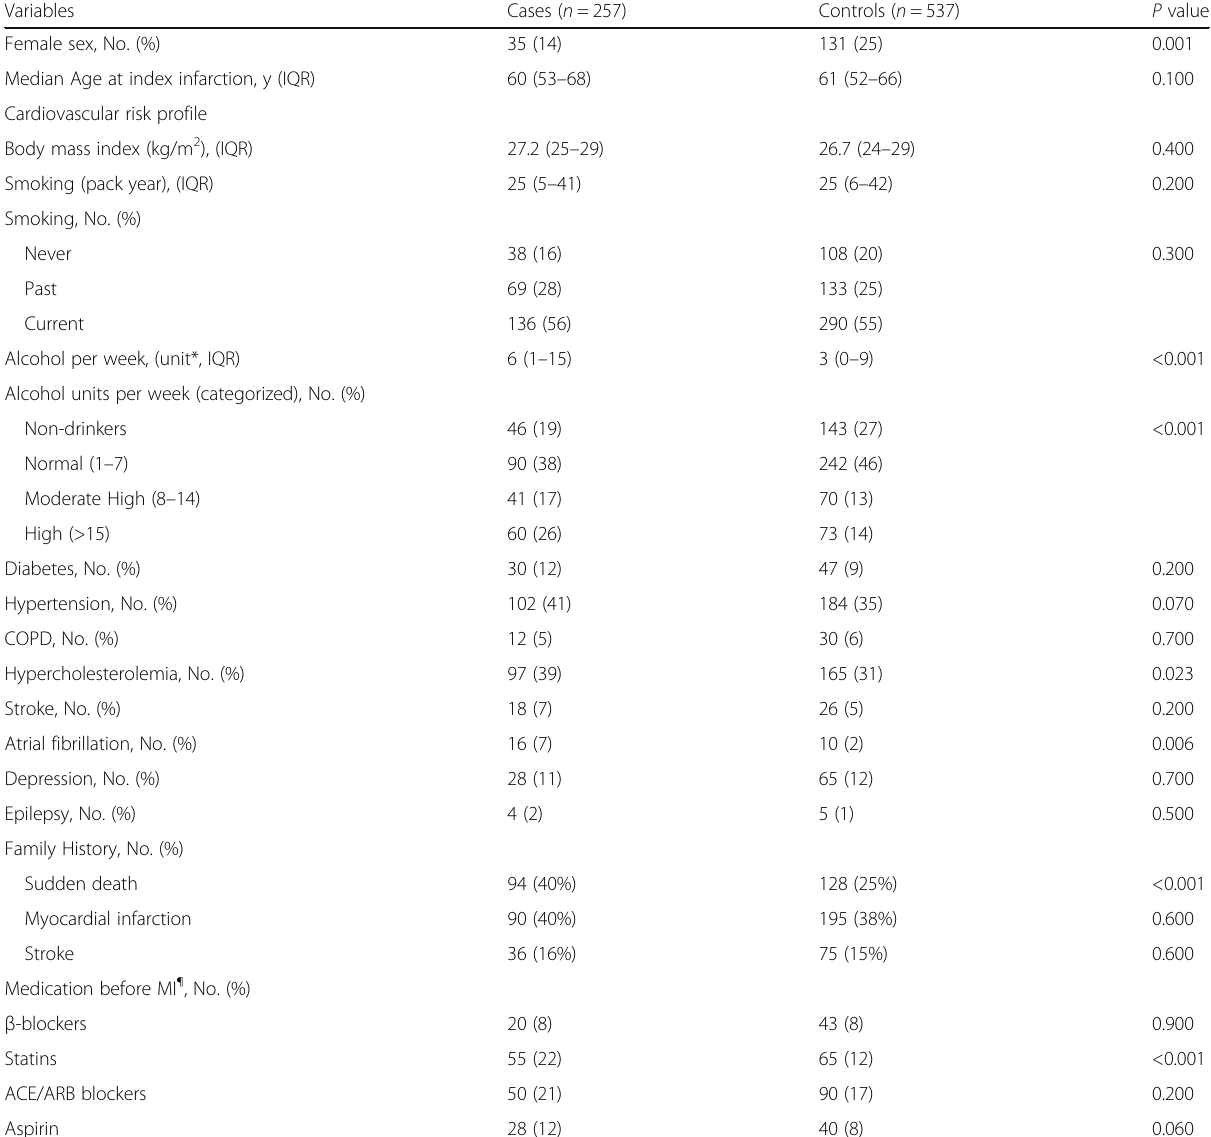
Table 1 Baseline characteristics of the cohort Variables Cases ( n =